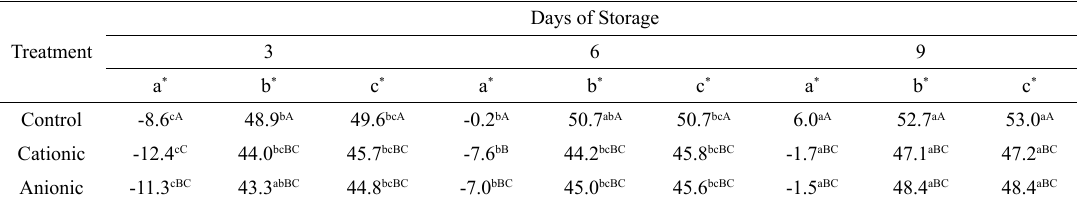
Table 3. Parameters a * , b * and chroma index for the color of the caja fruit.